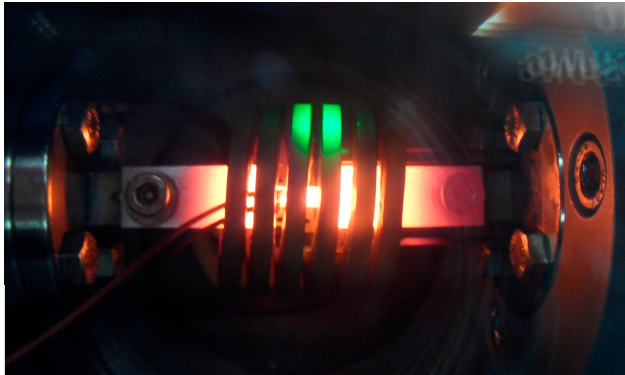
Figure 1. Austenitization of a specimen in the dilatometer.